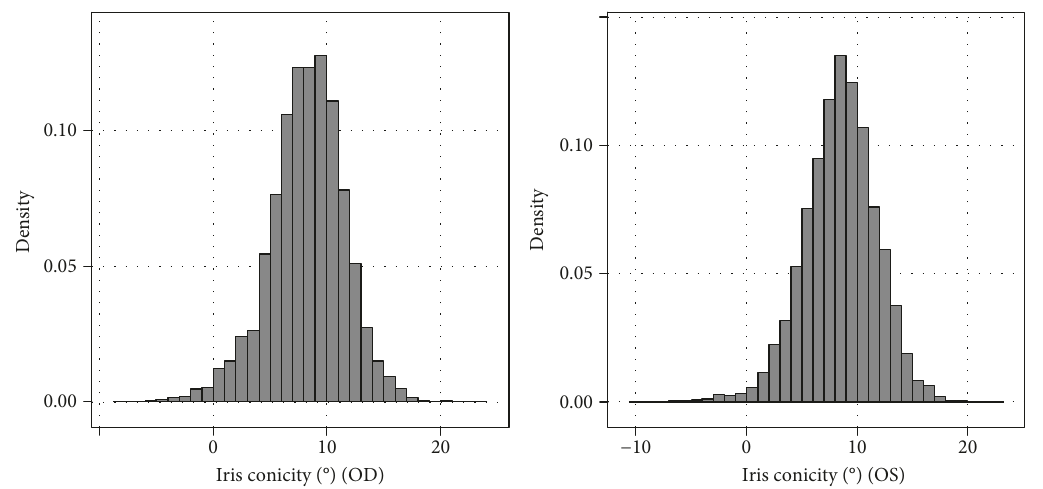
Figure 2: Distribution of iris conicity ( “ iris convexity, ” Pentacam) in the German population: the Gutenberg Health Study. (a) Right eyes. (b) Left eyes. Density is displayed as the proportion to the total study population (right eyes: 3060; left eyes: